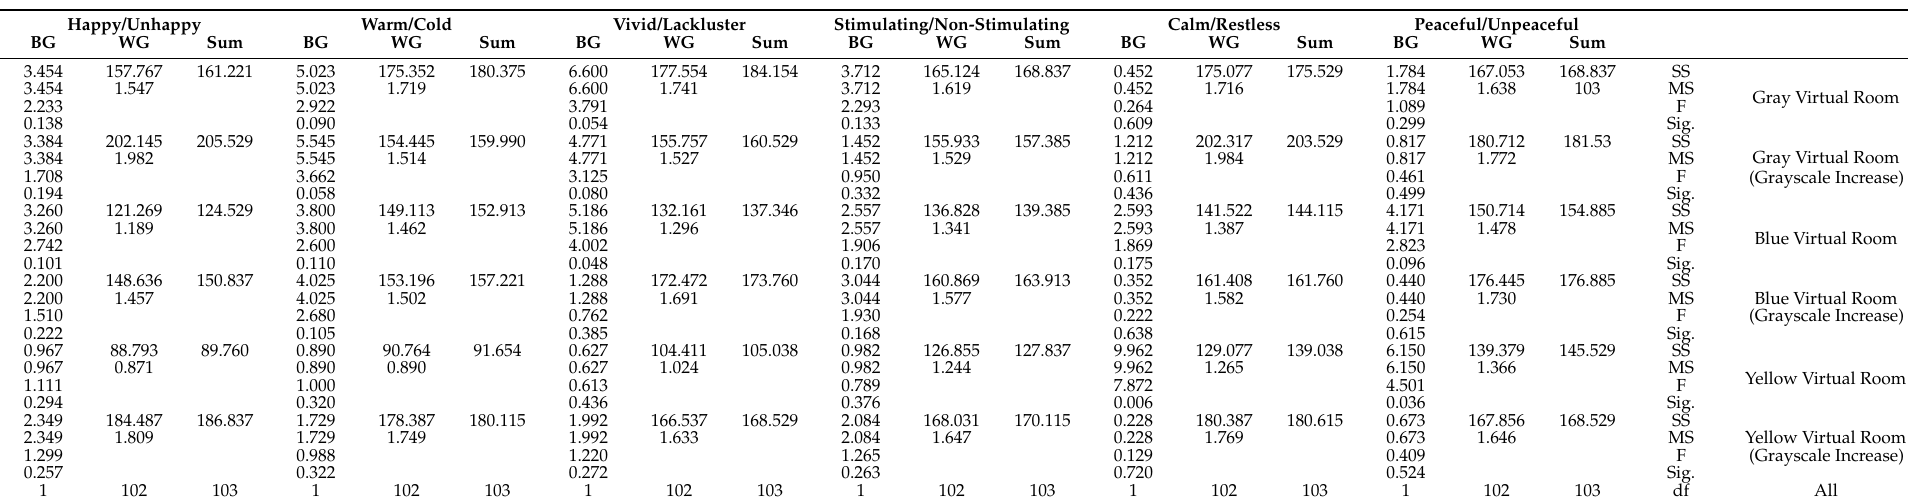
Table 7. Perception of different gender groups of the color of hotel indoor